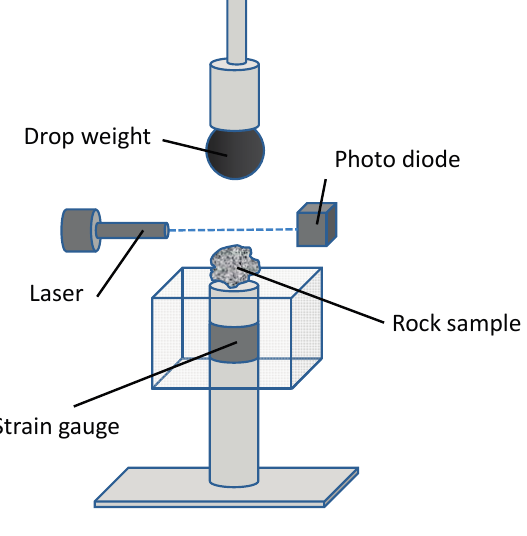
Figure 6. Ultra-fast load